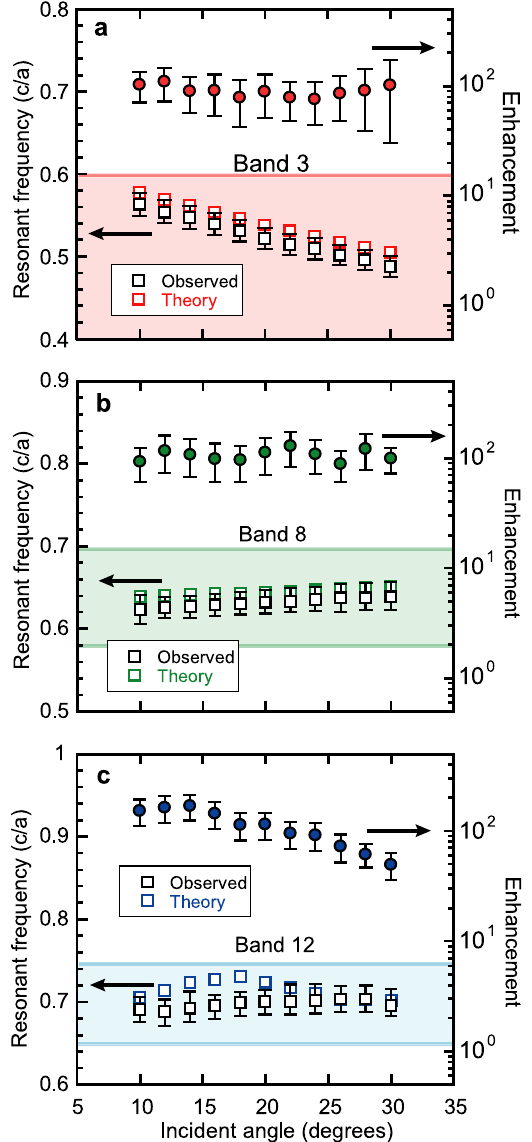
Figure 5. Absorption peak frequency and peak enhancement vs. incident angle. Locations of peak absorption enhancement in the frequency domain as a function of incident angle for ( a ) band 3, ( b ) band 8 and ( c ) band 12. Filled circles are measured enhancement at the peak frequency. Bounded boxes show the frequency range of each band. Enhancement error bars are determined from uncertainty in the reference film absorption measurement. Resonant frequency error bars account for statistical variance in the location of the resonant frequency, uncertainty in identifying an absorption peak with a particular band, and the fact that structural disorder in the PC may create additional absorption peaks that are not predicted by theory (see ref.